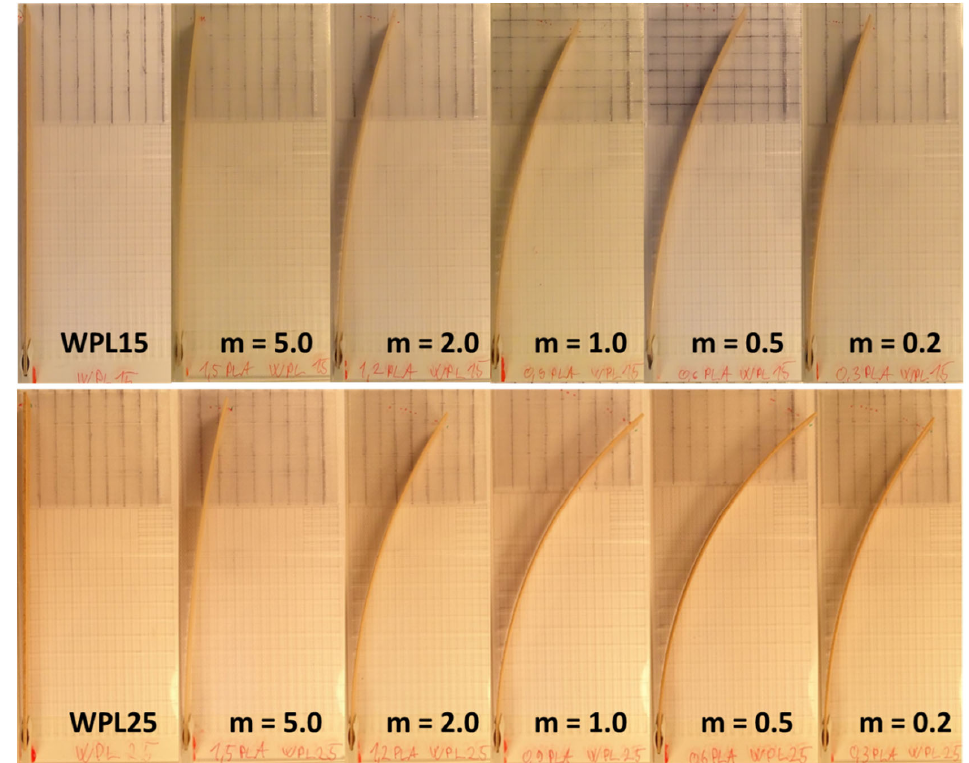
Figure 4. Curvature of WPL15 ( above ) and WPL25 ( bottom ) specimens at the end of the humidification process (168 h at 80% RH and 20 °C) First specimen in a row is pure WPL; from left the thickness of passive (PLA) to active (WPL) decreases from 5.0 to 0.2.